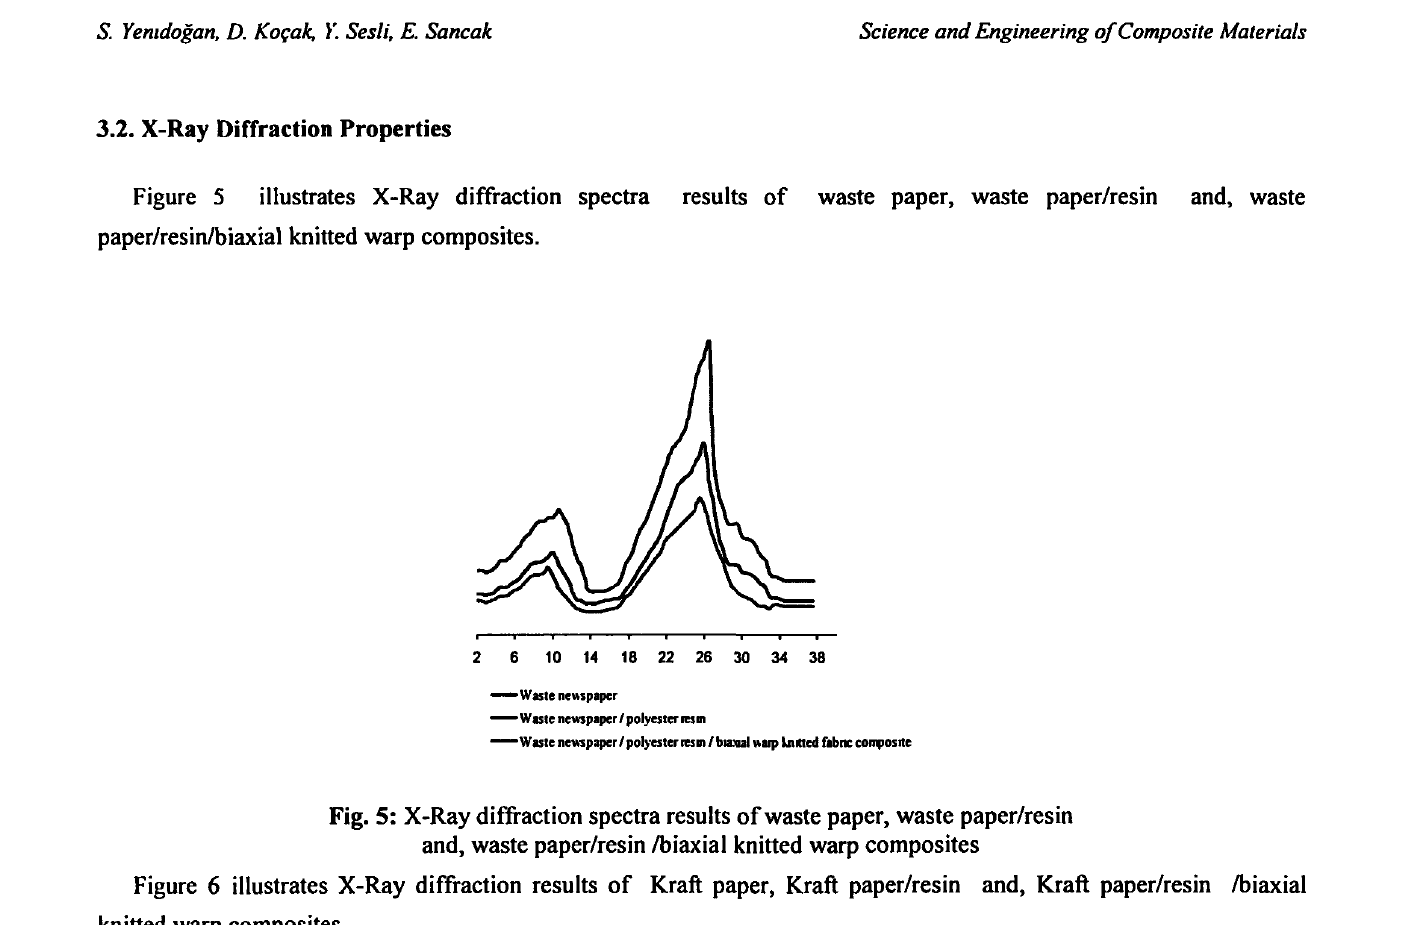
Fig. 5: X-Ray diffraction spectra results of waste paper, waste paper/resin and, waste paper/resin /biaxial knitted warp composites